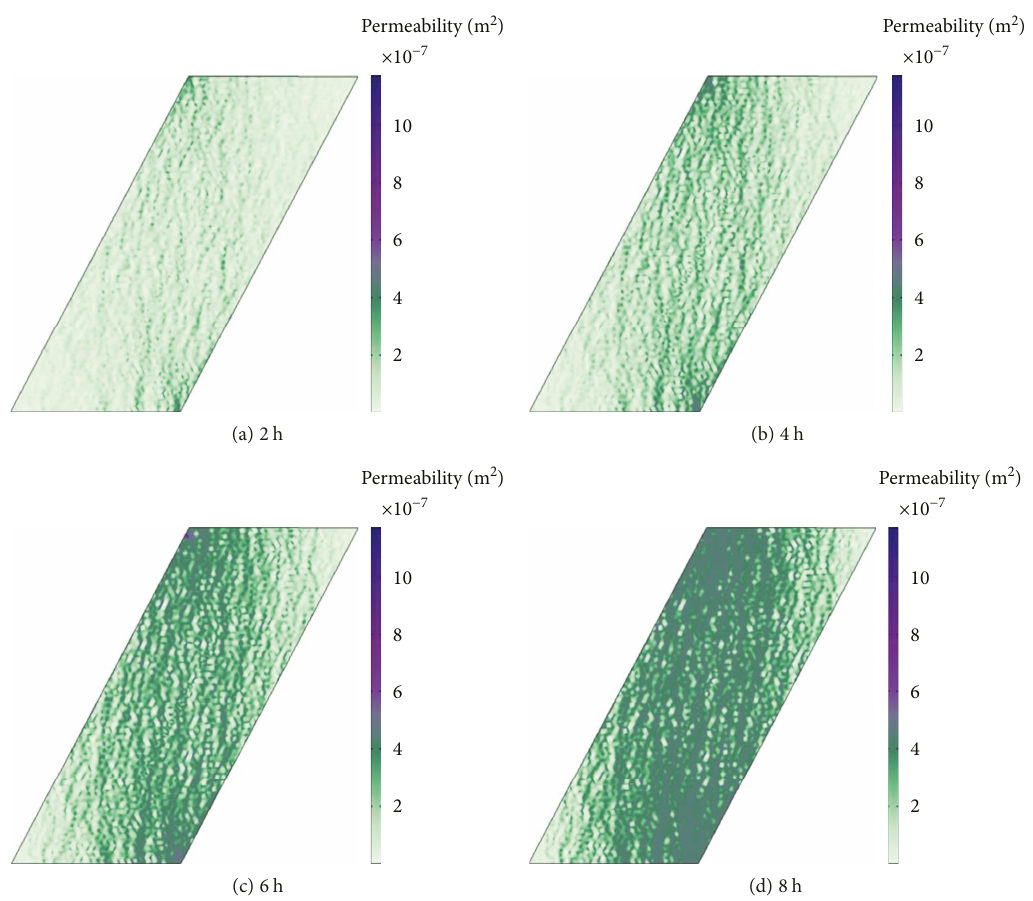
Figure 9: The spatial distribution of permeability at di ff erent times.